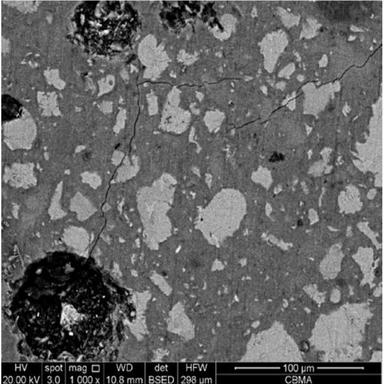
Image of internal expansive damage of the material under the effect of subsequent hydration.